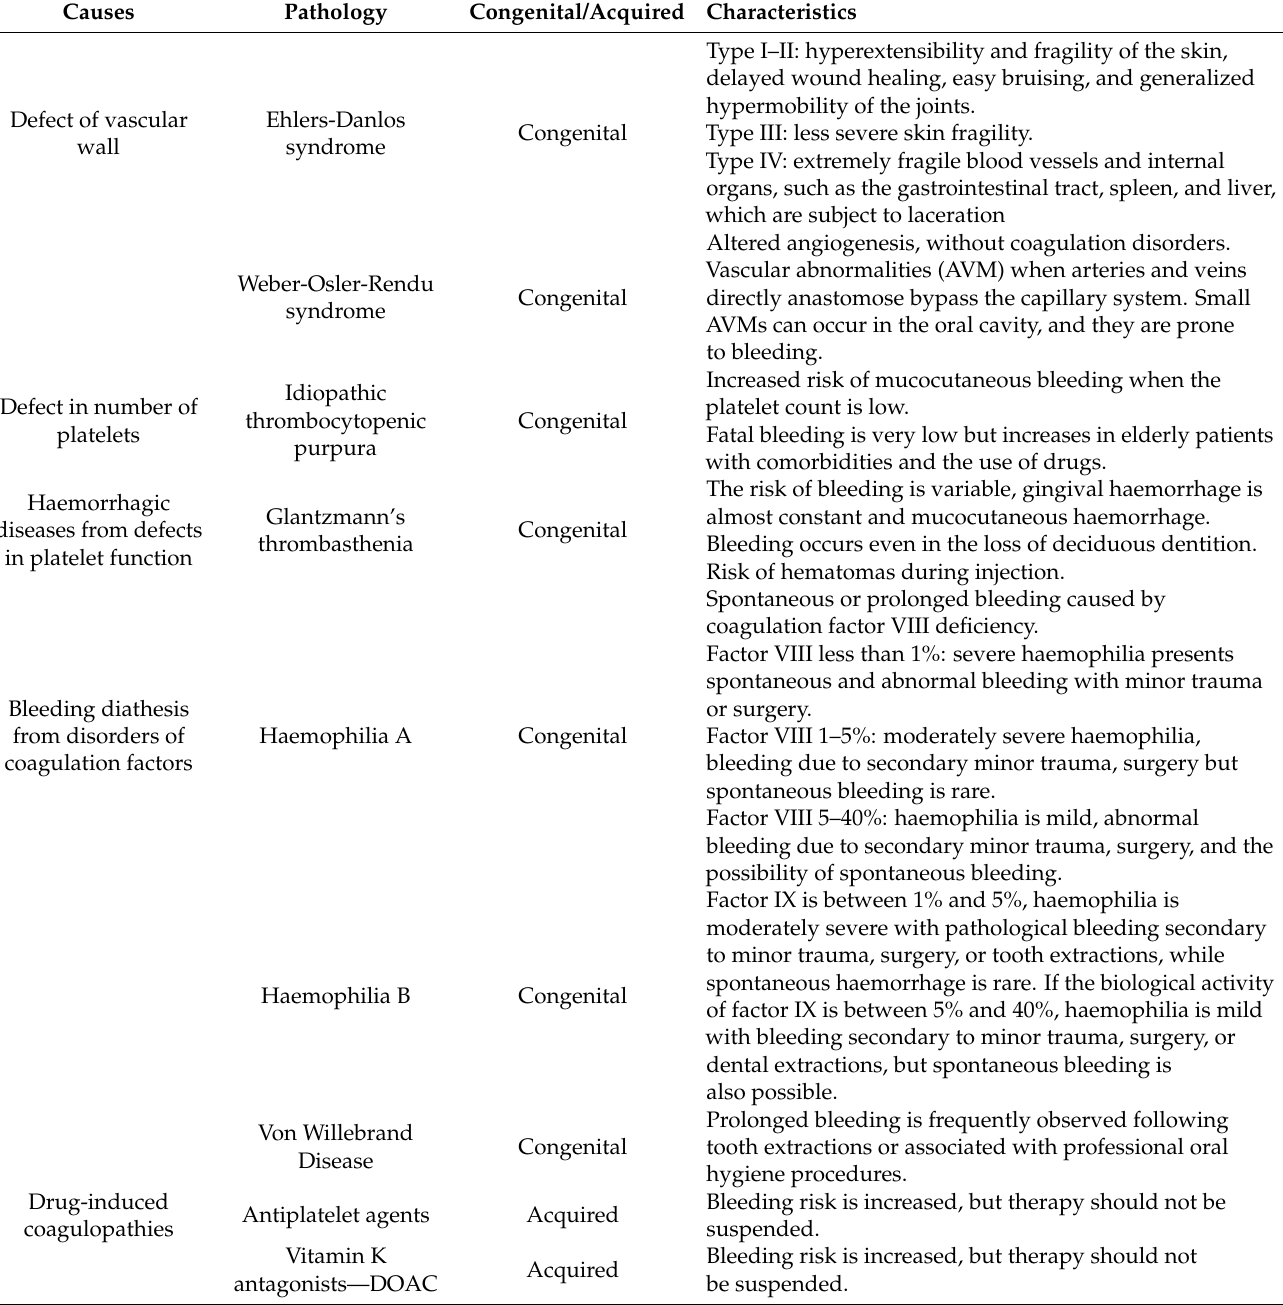
Table 1. Haemostasis disorders and risk of